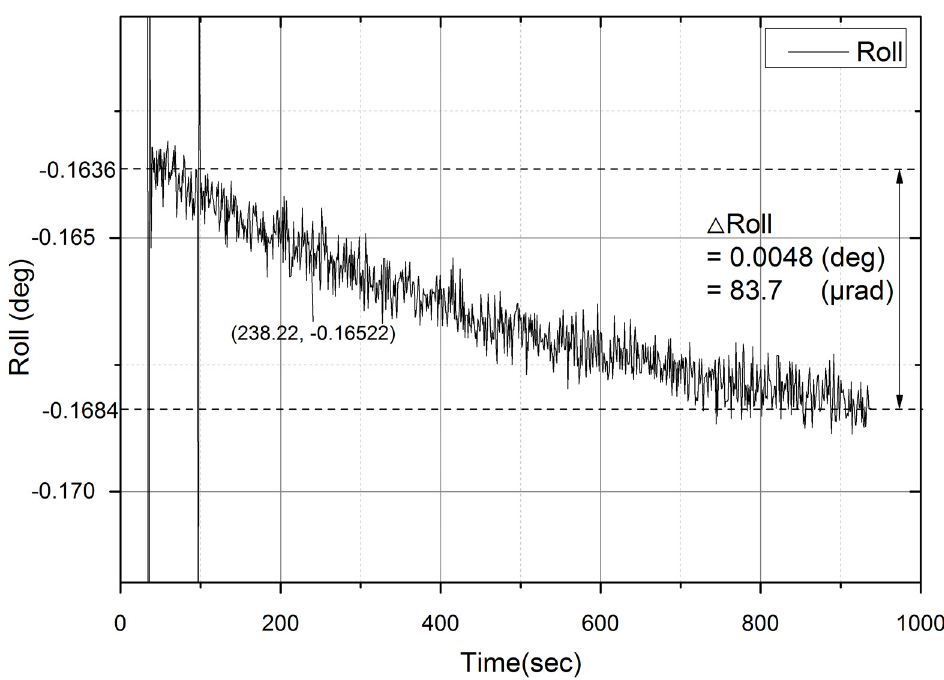
Figure 8. The drift of a roll angle during a self-alignment experiment. Even though the Inertial Navigation System (INS) was stationary, the roll angle gradually decreased, and the amount of the decrement became 0.0048° at 900 sec. This roll angle variation is caused by accelerometer temperature stabilizing error.